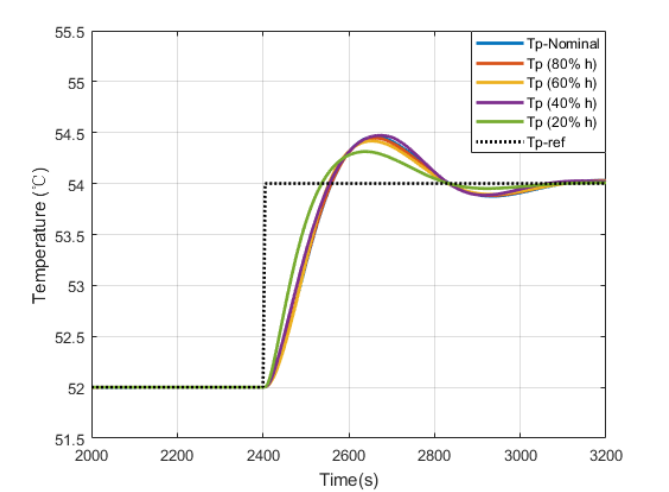
Figure 6. Performances of controller banks under the same reference Tp-refafter